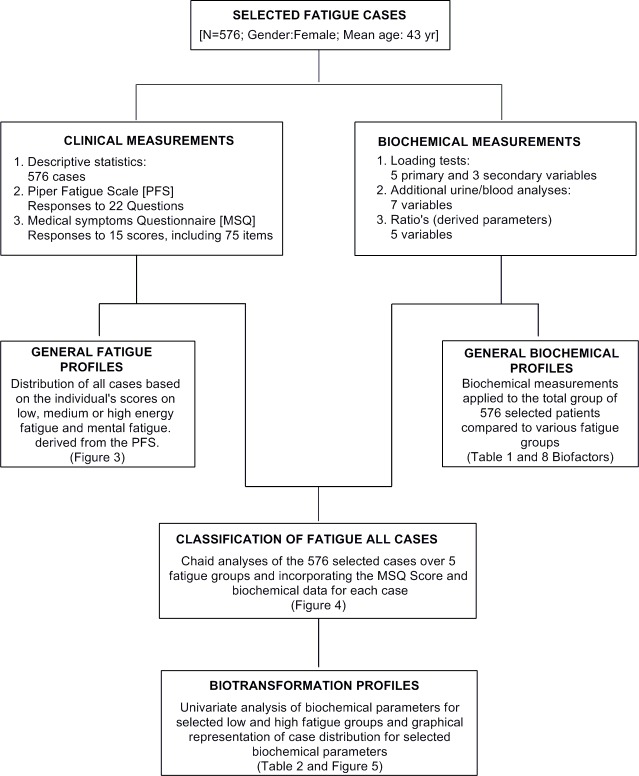
Schematic flow diagram for the analysis of clinical and biochemical data for exploratory biotransformation profiling of samples from all fatigue patients.